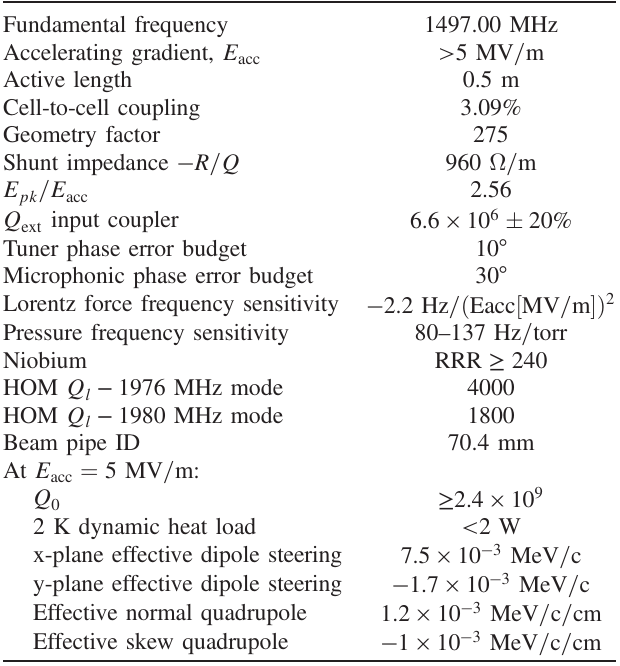
TABLE II. CEBAF SRF cavity design